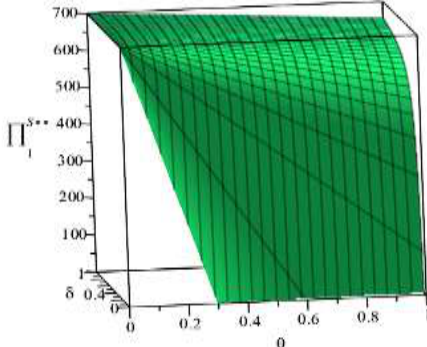
Figure 6. Effect of manufacturer's behavior 𝜃 、 𝛿 on business flow network under performance conditions.